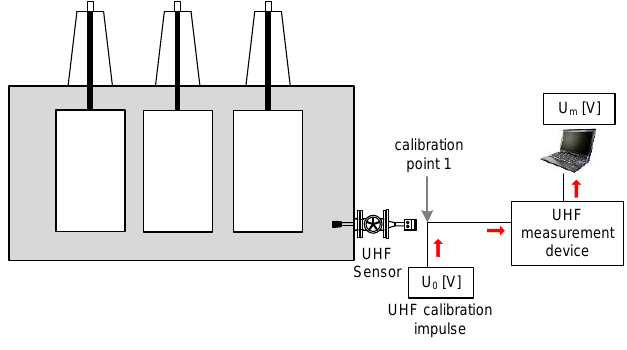
Figure 5 . Calibration of measurement device and cables [13]. Figure 5. Calibration of measurement device and cables [13]. Figure 5. Calibration of measurement device and cables